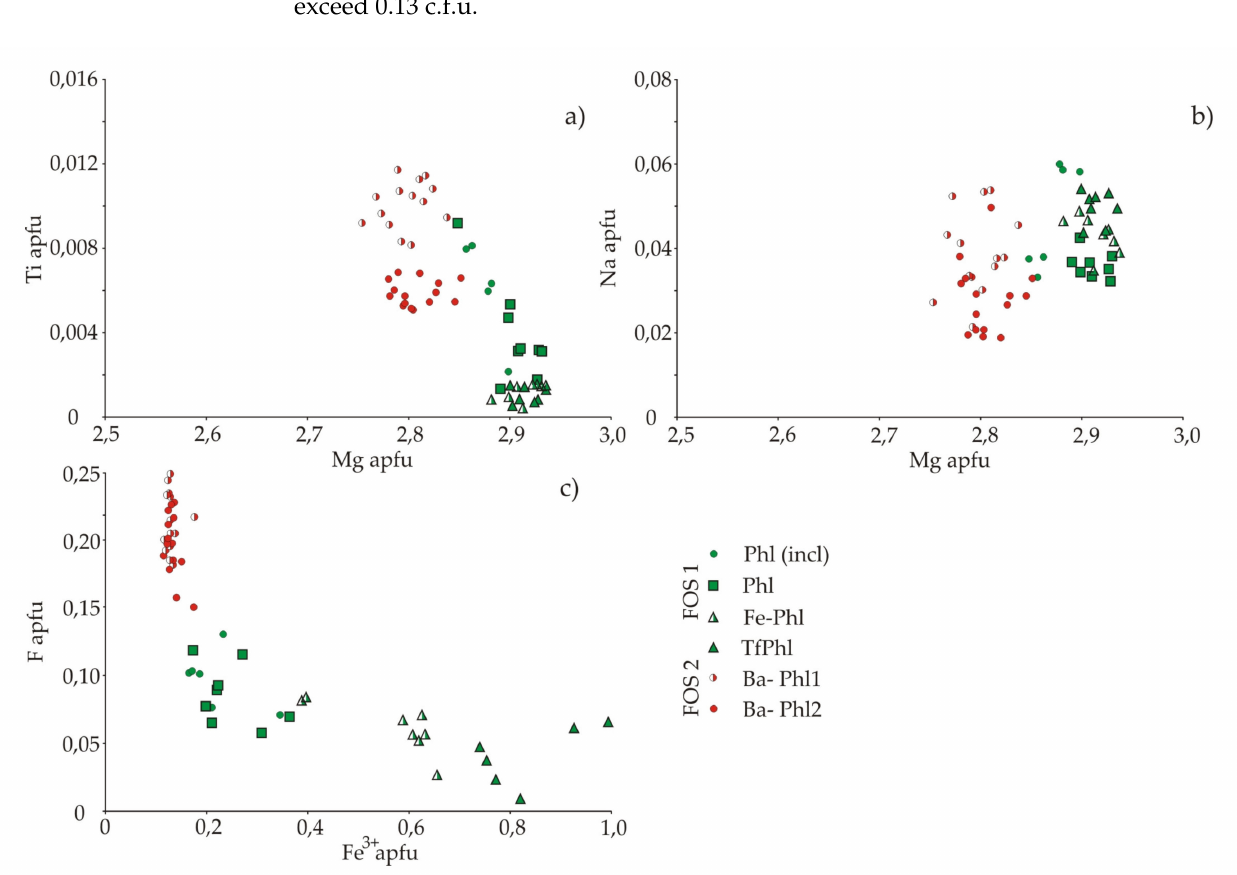
Figure 6. Variation of phlogopite compositions from Arbrastach phoscorites ( a ) Ti; ( b ) Na versus Mg, ( c ) shows a diagram of Fe 3+